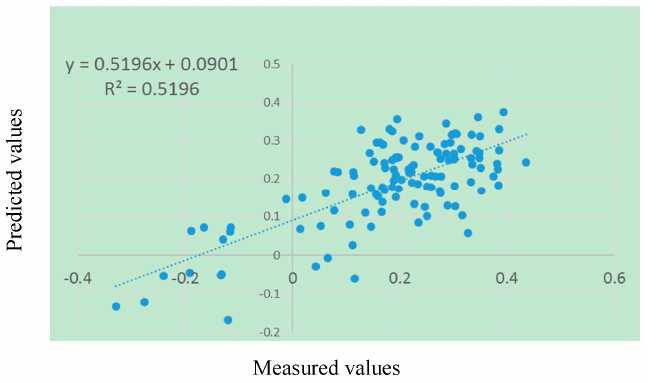
Figure 14. The fitting relationship between the measured and the predicted values of lnp (p: perme- ability coefficient) using the model. Spatial distribution and the determination coefficient (R 2 ) show a good data-fitting effect.